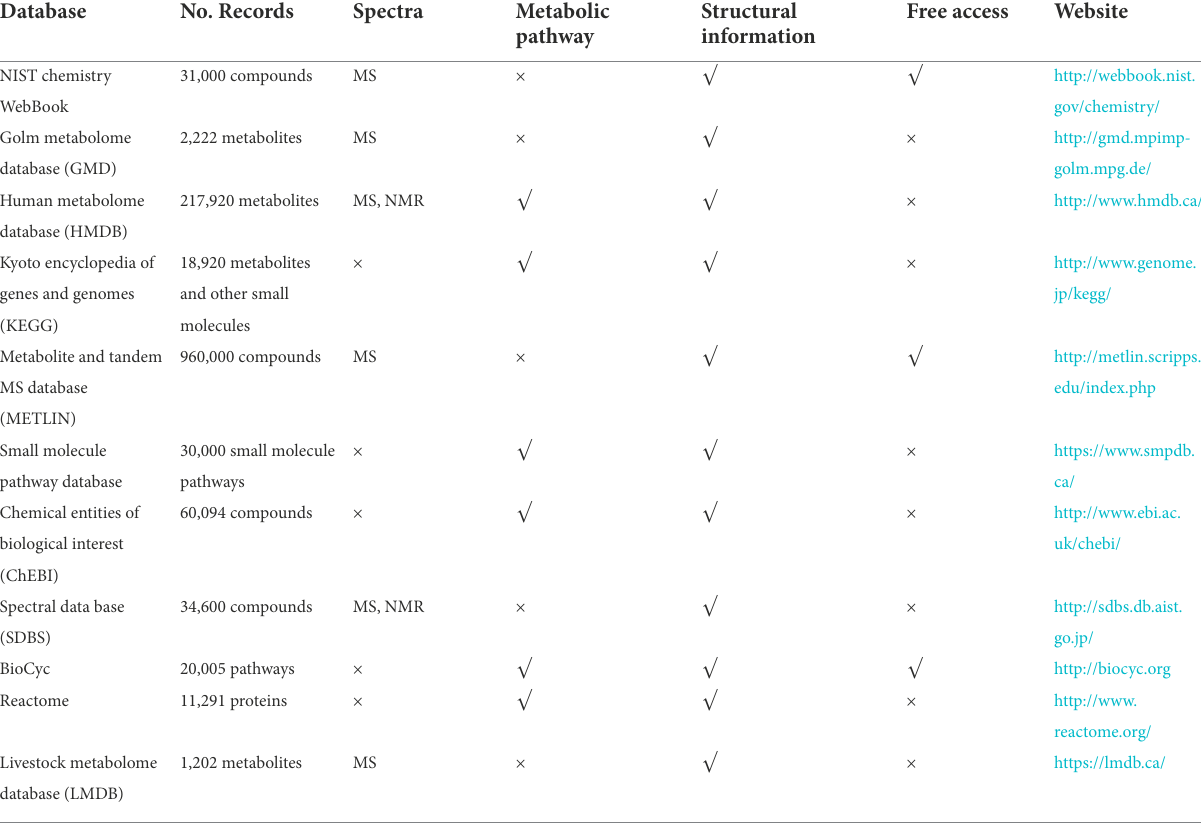
TABLE 2 Comparison of commonly used metabolome